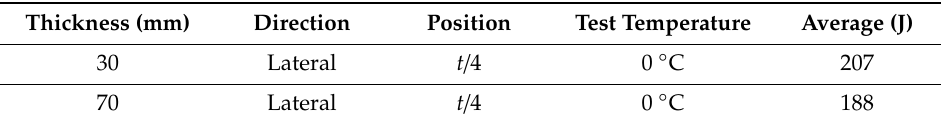
Table 8. Charpy V-notch impact test results depending on the thickness and positions of the SN 490C plates.